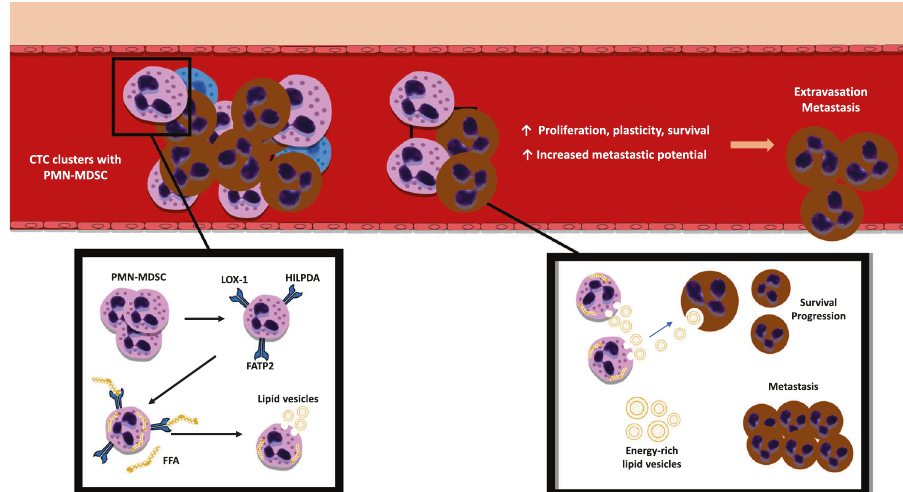
Fig. 4 PMN-MDSC travel in clusters with CTC and stromal cells in the bloodstream. PMN-MDSC fuel the proliferation and survival of CTC by providing them with energy-rich lipid vesicles. The proximity of PMN-MDSC to CTC promotes the plasticity of CTC and increases their metastatic potential. In the TME, PMN-MDSCs accelerate their own lipid transfer, uptake, and storage of lipids through increased expression of FATP2, HILDPA, and LOX1 proteins. CTC circulating tumor cell, FATP2 fatty acid transporter protein 2, FFA free fatty acids, HILDPA hypoxia- inducible lipid droplet-associated protein, LOX1 lectin-like oxidized low-density lipoprotein